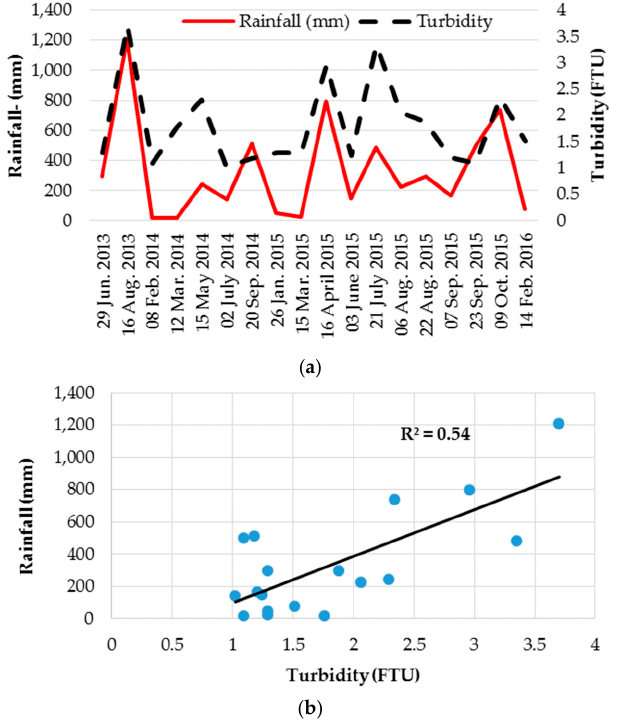
Figure 16. ( a ) Time series of measured rainfalls and the mean Landsat 8 OLI extracted turbidities and ( b ) their correlation. ( b ) their